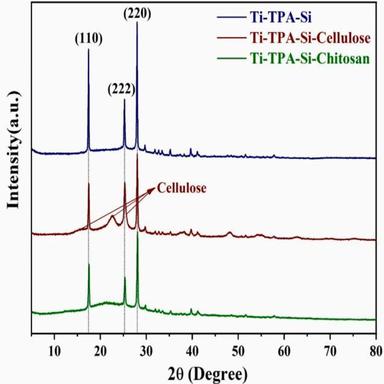
X-ray diffraction patterns of Ti-TPA-Si, Ti-TPA-Si-C, and Ti-TPA-Si-CS.